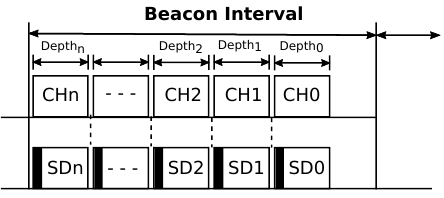
Figure 3. Bottom-up cluster active period